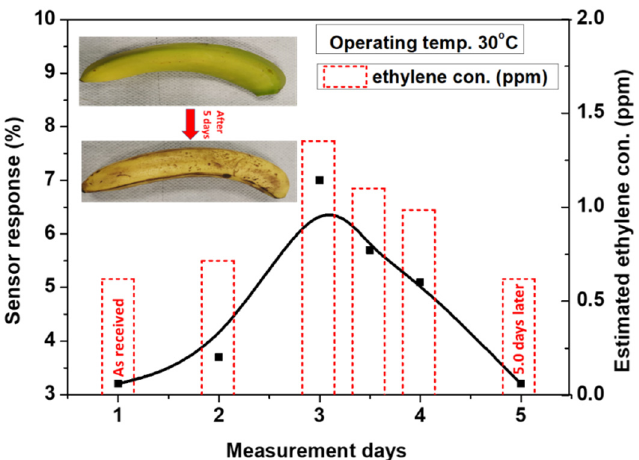
Figure 14. Sensor response of a single banana as a function of the ripening days, detecting the ripening of banana over five days.